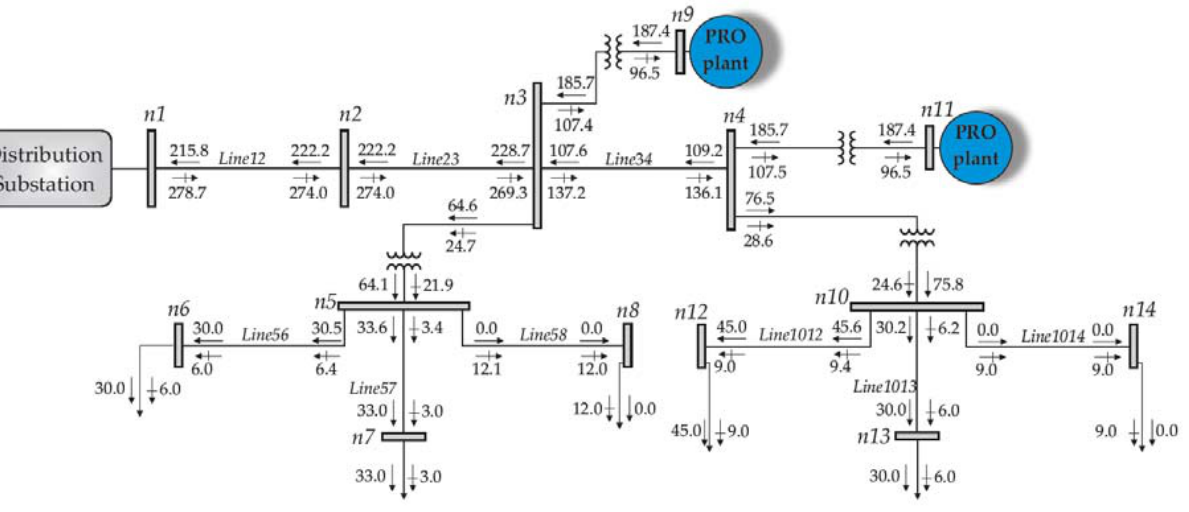
Figure 12. Three ‐ phase complex power flow diagram for the base case. Figure 12. Three-phase complex power flow diagram for the base